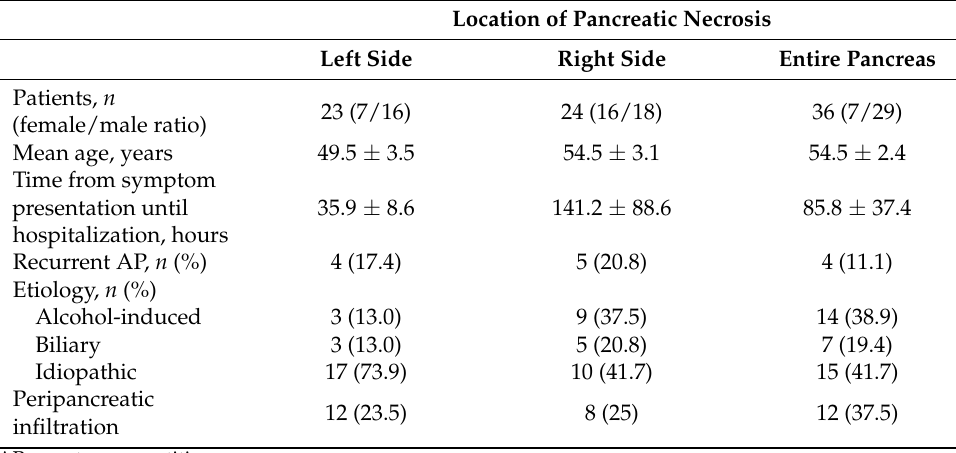
Table 2. Clinical data by the location of pancreatic